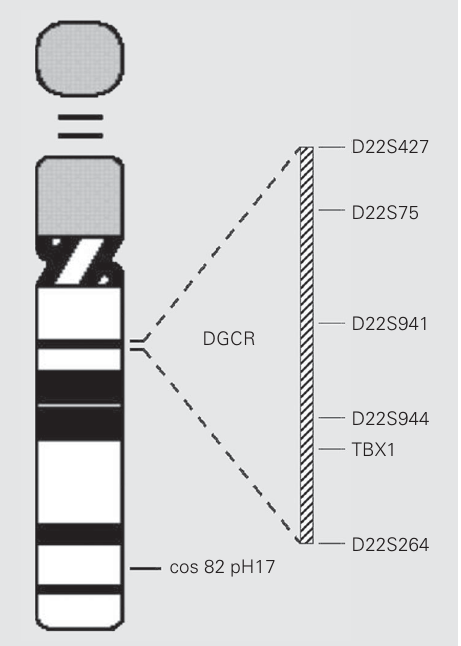
Figure 1. Idiogram of chromo- some 22 illustrating the com- monly deleted region [DiGeorge syndrome chromosome region (DGCR); hatched box], the rela- tive location of the tested mark- ers, and the location of the hu- man T-box gene